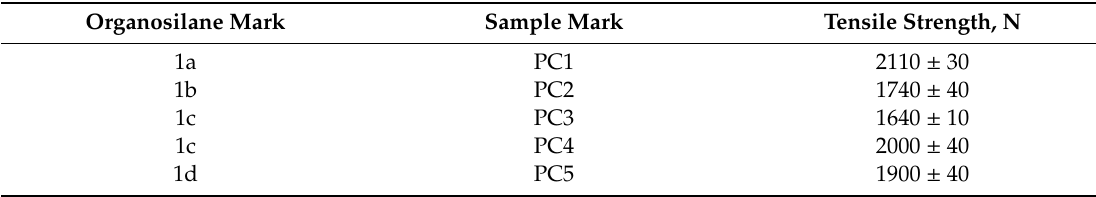
Table 6. Tensile strength measurement